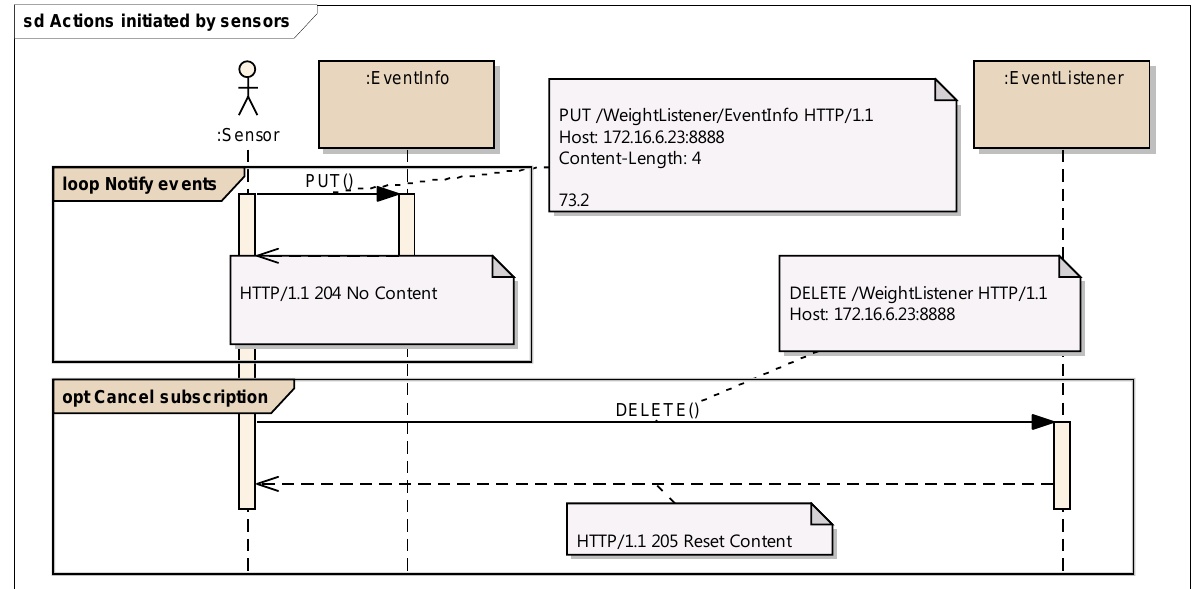
Figure 9. Interactions with resources of event